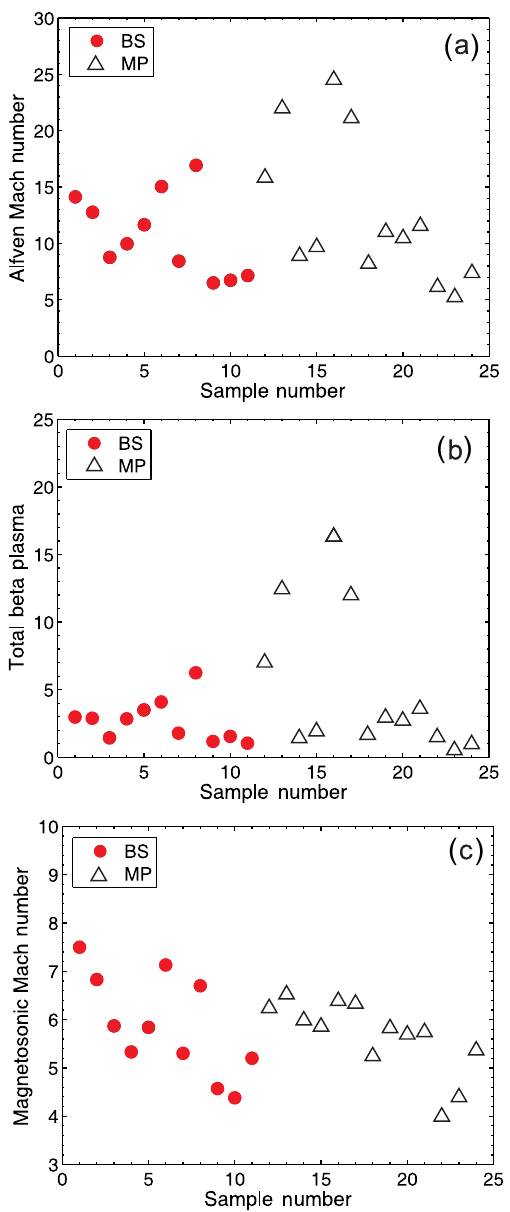
Figure 8. Alfvén Mach number (a) , total plasma beta (b) , and mag- netosonic Mach number (c) near the bow shock (BS, red circles) and the magnetopause (MP, white